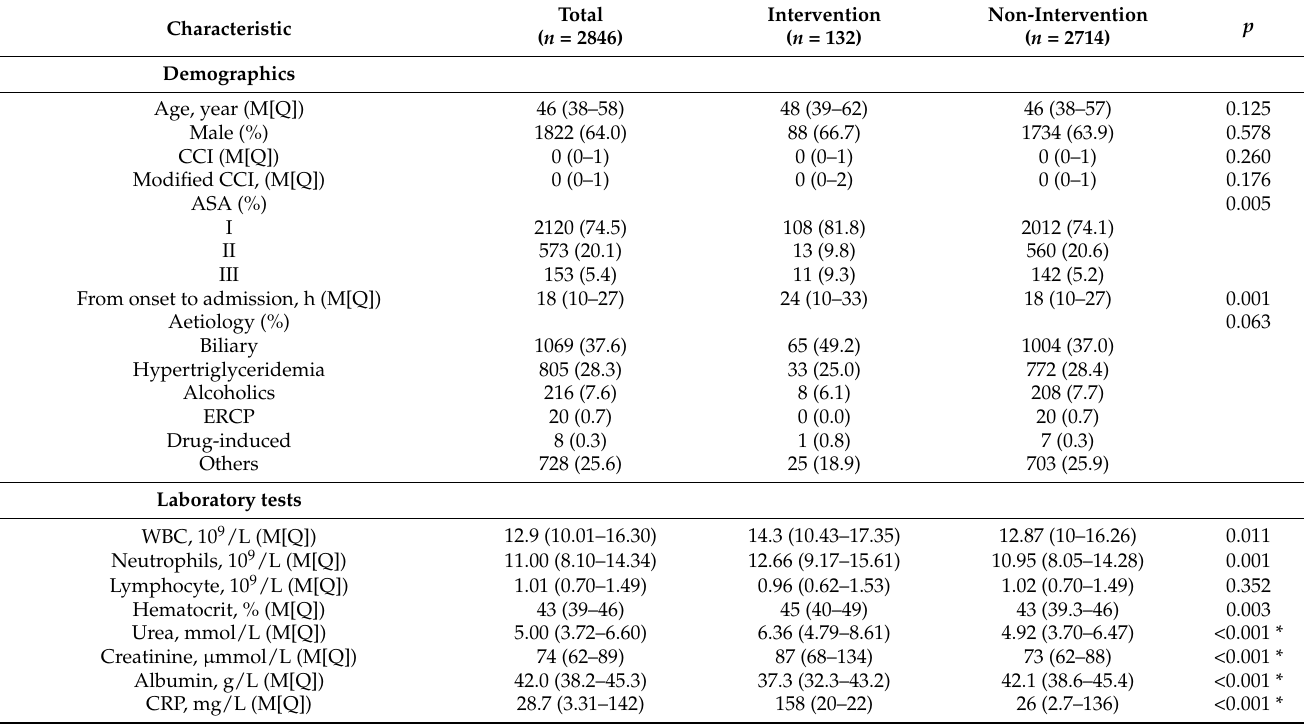
Table 1. Characteristics between intervention and non-intervention patients with